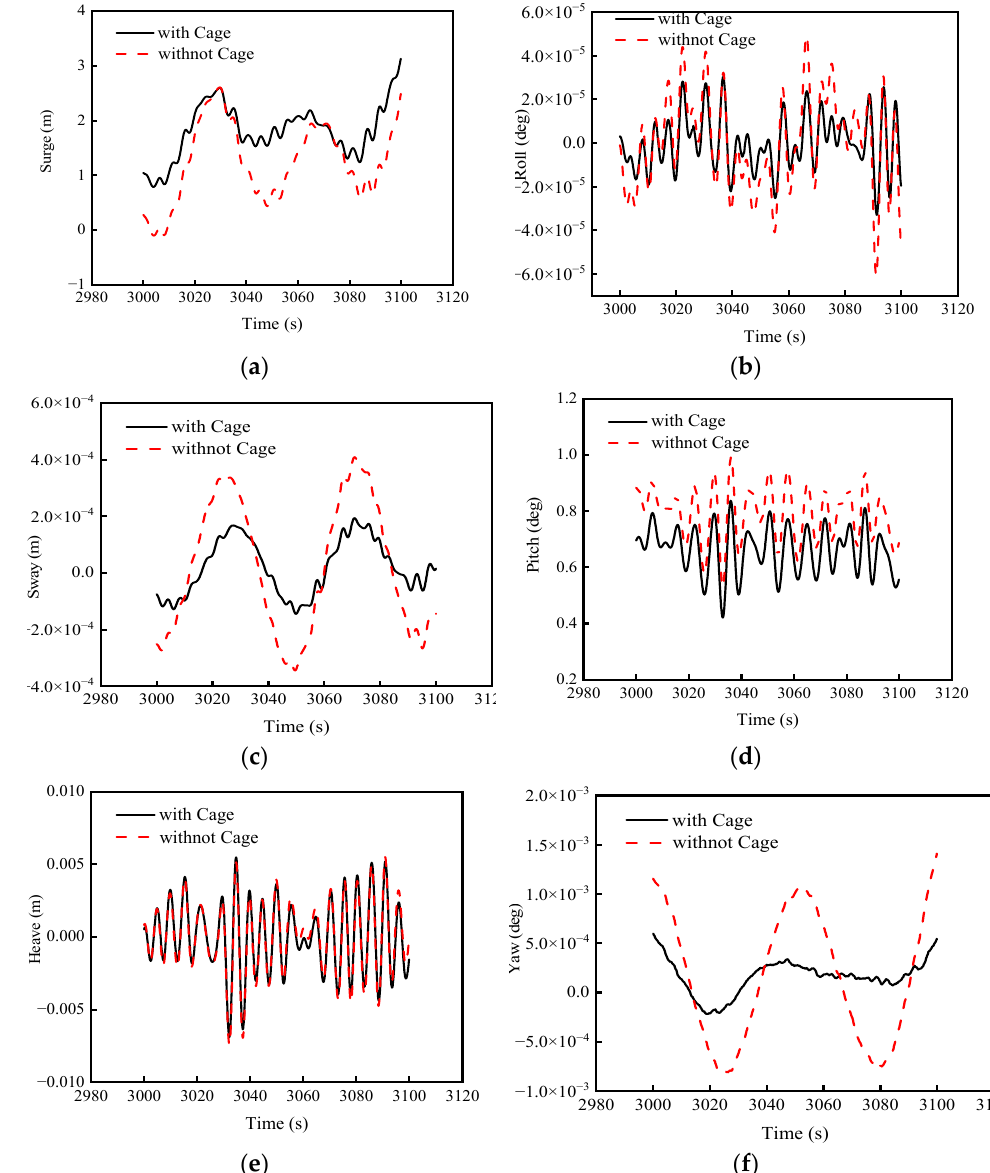
Figure 14. Comparison diagram of the motion response of the barge-type FOWT-AC and barge-type FOWT under EC1: ( a ) Time histories of surge motion; ( b ) Time histories of roll motion; ( c ) Time histories of sway motion; ( d ) Time histories of pitch motion; ( e ) Time histories of heave motion; ( f ) Time histories of yaw